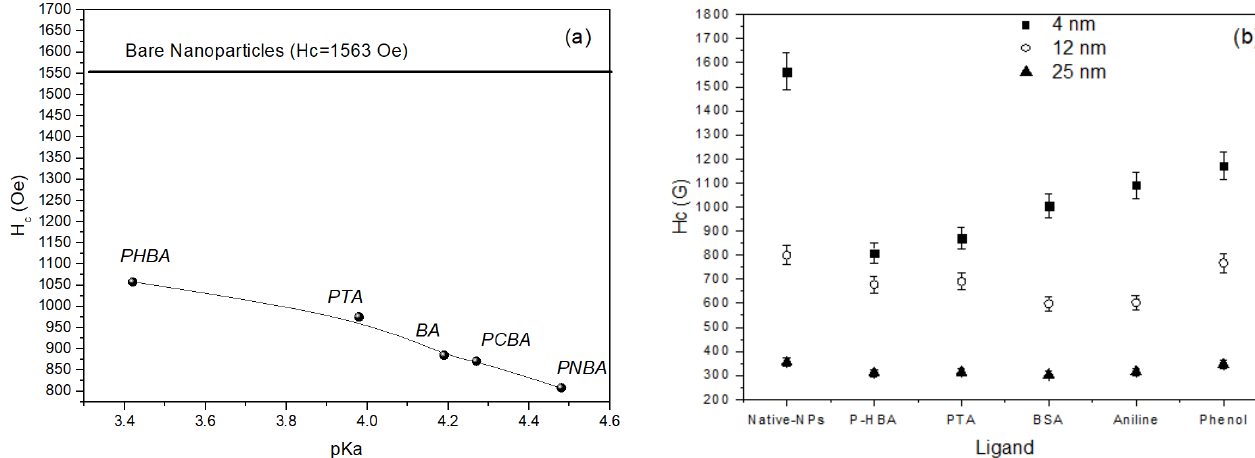
Figure 4. ( a ) variation of coercivity with pKa of MnFe 2 O 4 coated with different ligands: p -hydroxybenzoic acid (PHBA), p -toluic acid (PTA), benzoic acid (BA), p -chlorobenzoic acid (PCBA), p -nitrobenzoic acid (PNBA)). Coercivity of bare nanoparticles is reported as a reference; ( b ) variation of coercivity nanoparticles of different sizes coated with different ligands: p -hydroxybenzoic acid (PHBA), p -toluic acid (PTA), benzenesulfonic acid (BSA) aniline and phenol.